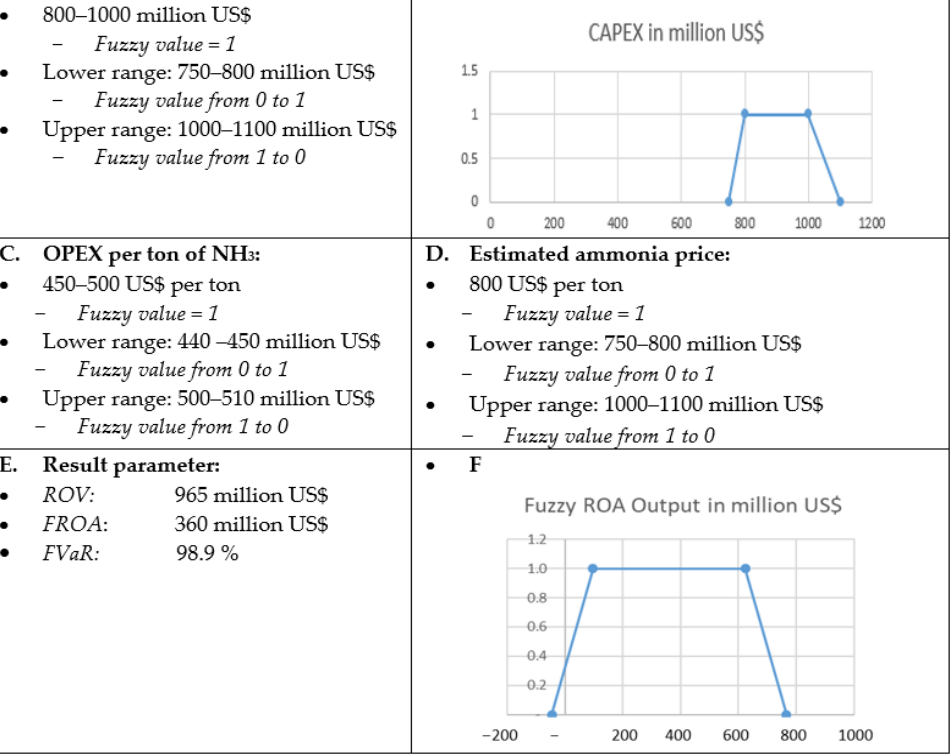
Figure 1. Fuzzy real options analysis (FROA) for Estonia’s Ammonia Plant. ( A ) CAPEX of the NH 3 Plant at fuzzy value. ( B ) Trapezoidal CAPEX from fuzzy calculation. ( C ) OPEX per ton of NH 3 at fuzzy value. ( D ) Estimated ammonia price at fuzzy value. ( E ) Results of the FROA, Return of Value (ROV) from the fuzzy mean of the possibility distribution, and fuzzy value at risk (FVaR). ( F ) Final FROA trapezoid.